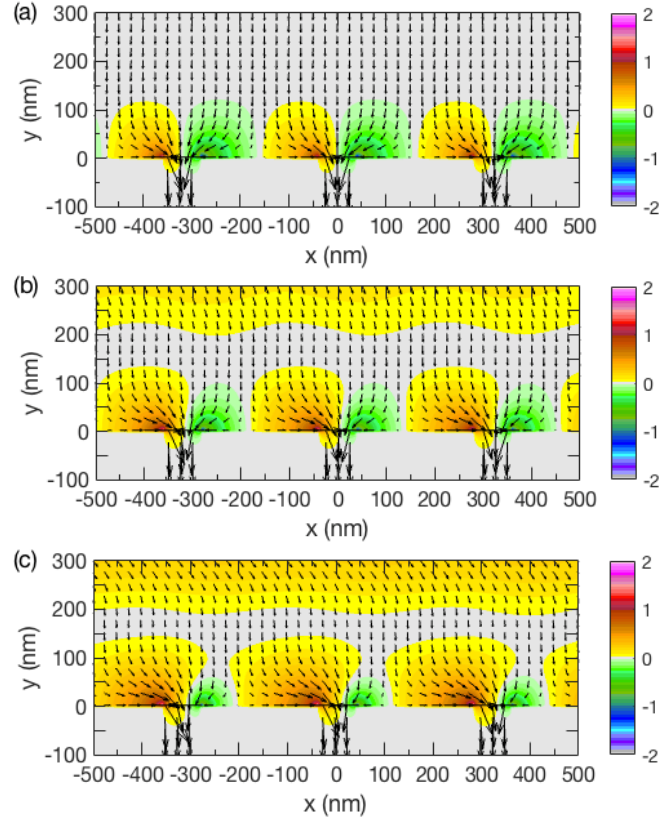
Nanomaterials 2022 , 12 , x FOR PEER REVIEW 5 of 9